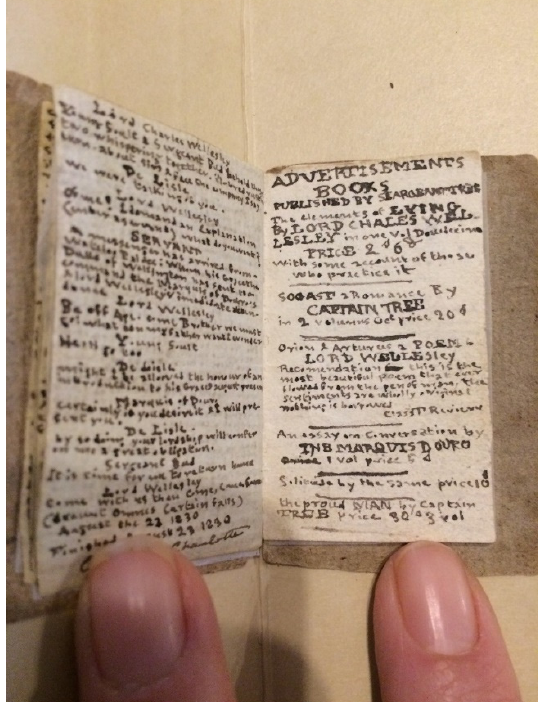
Figure 5. The Advertisements page of the Young Men’s Magazine.